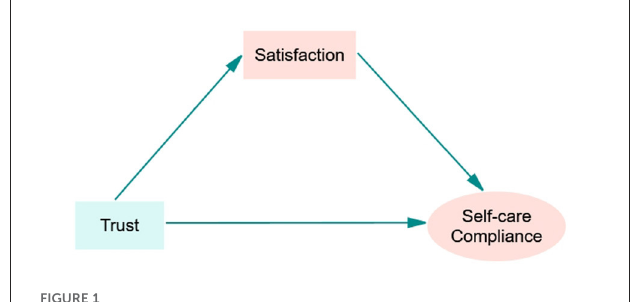
such as dietary salt reduction, physical activity, and potassium intake.